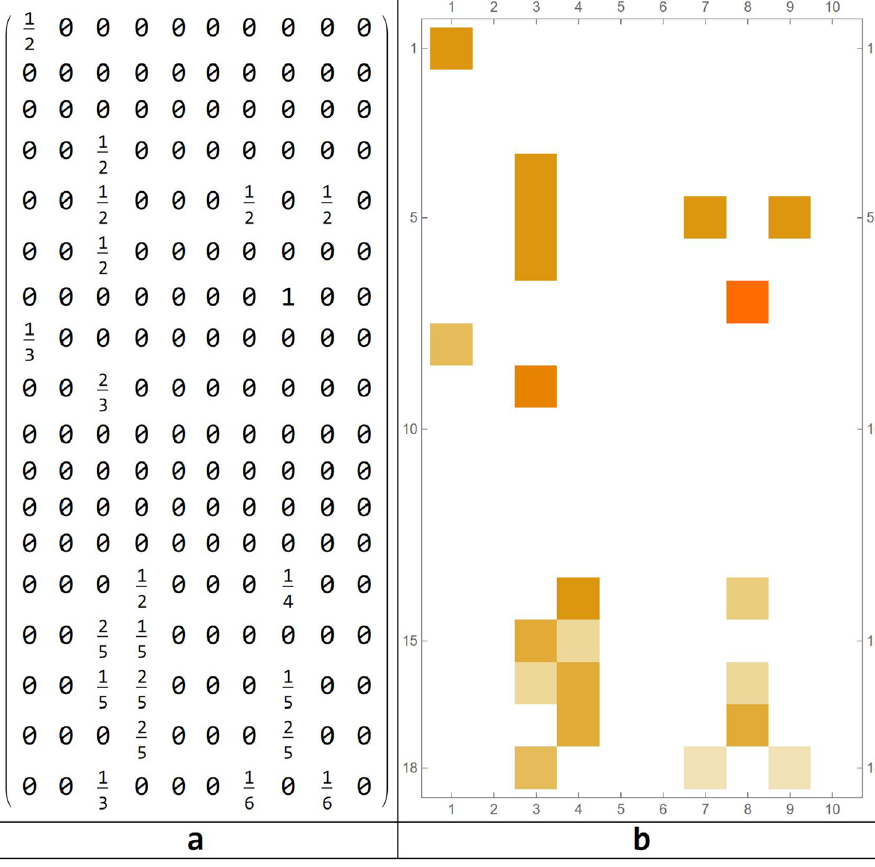
Figure 15. Intersection array ( a ) and correlation matrix for different simulation parameters ( b